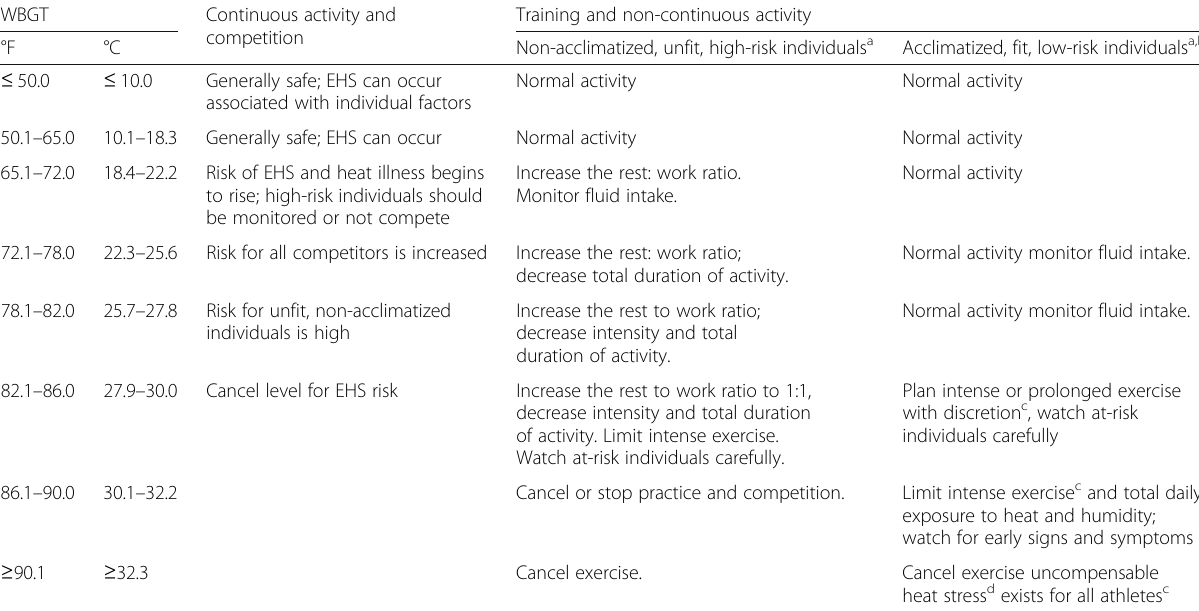
Table 1 Wet-bulb globe temperature (WBGT) levels for modification or cancelation of workouts or competition for healthy adults